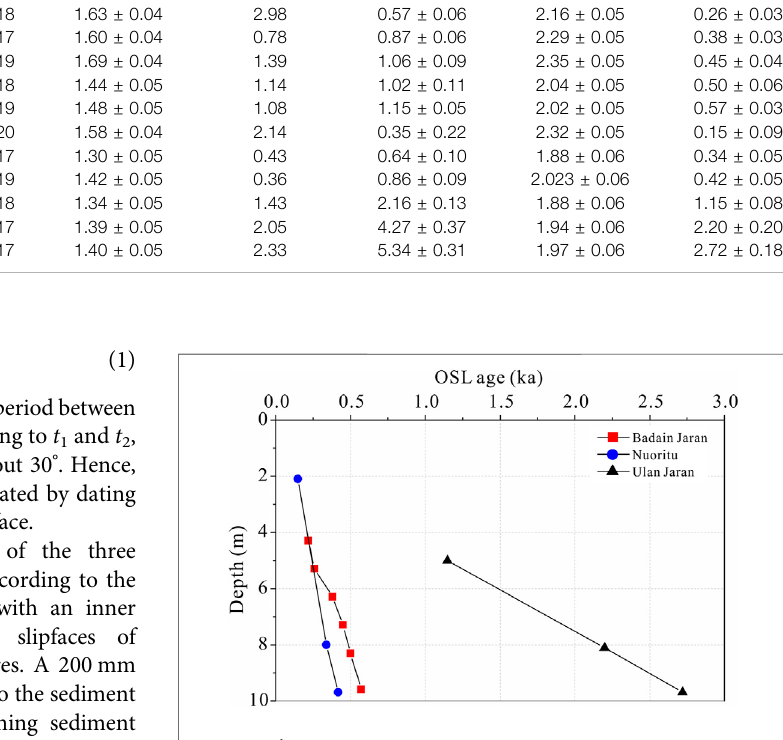
FIGURE 2 | OSL age-depth pro fi les of the three